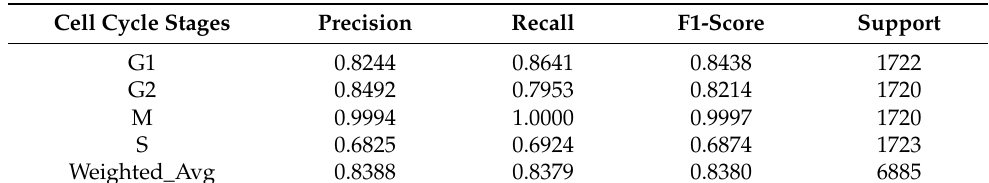
Table 8. The four-stage classification results for images generated by WGAN-GP.